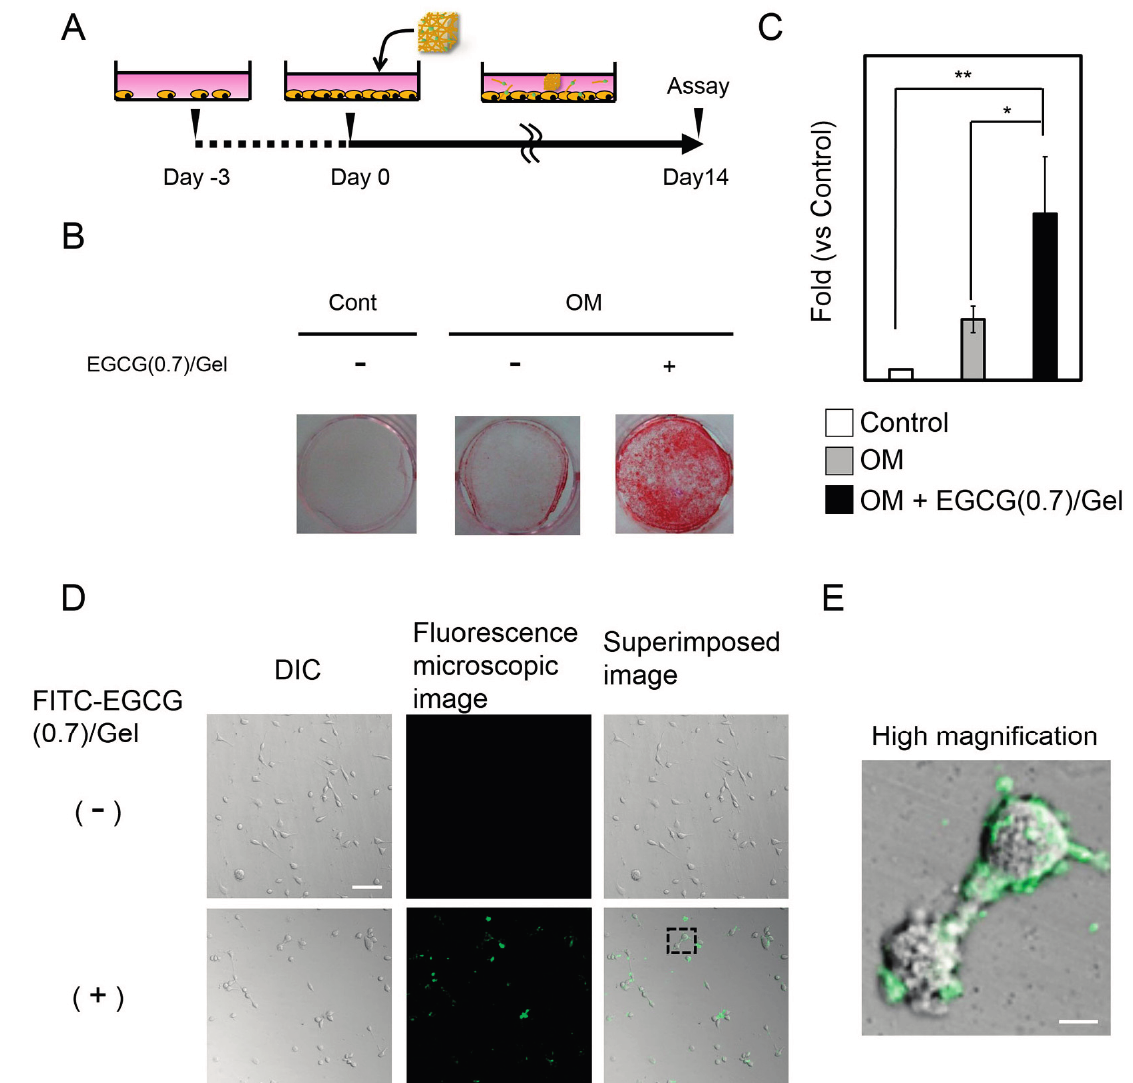
Figure 6. Effects of EGCG/Gels on the osteoblastogenesis of D1 cells in vitro . ( A ) Scheme of the experiment; ( B , C ) Alizarin red staining and its quantification data for the D1 cells treated with/without EGCG/Gels; ( A – C ) D1 cells were seeded at 1 × 10 5 cells/well in a 24-well plate. On the prescribed date, the EGCG/Gel was added to the media. The mineralized matrix was stained with alizarin red S on Day 14. Cont: Control medium. OM: Osteogenic medium. + designated as 600 μ g EGCG (0.7)/Gel. * p < 0.05, ** p < 0.01 (ANOVA with a Tukey-Kramer test). Data represent the mean with standard deviation ( n = 3 per group); and ( D , E ) DIC and fluorescence microscopy images of the cells treated with FITC-labeled EGCG/Gel at low and high magnification. D1 cells were seeded at 1000 cells/well in 96-well plates. After overnight incubation, the cells were treated with approximately 20 μ g of FITC-labeled EGCG (0.7)/Gel for 24 h. Dashed line square: magnified area. FITC-labeled EGCG/Gel adsorbed onto the cell surface of the D1 cells. Bars: ( D ) 100 μ m and ( E ) 10 μ